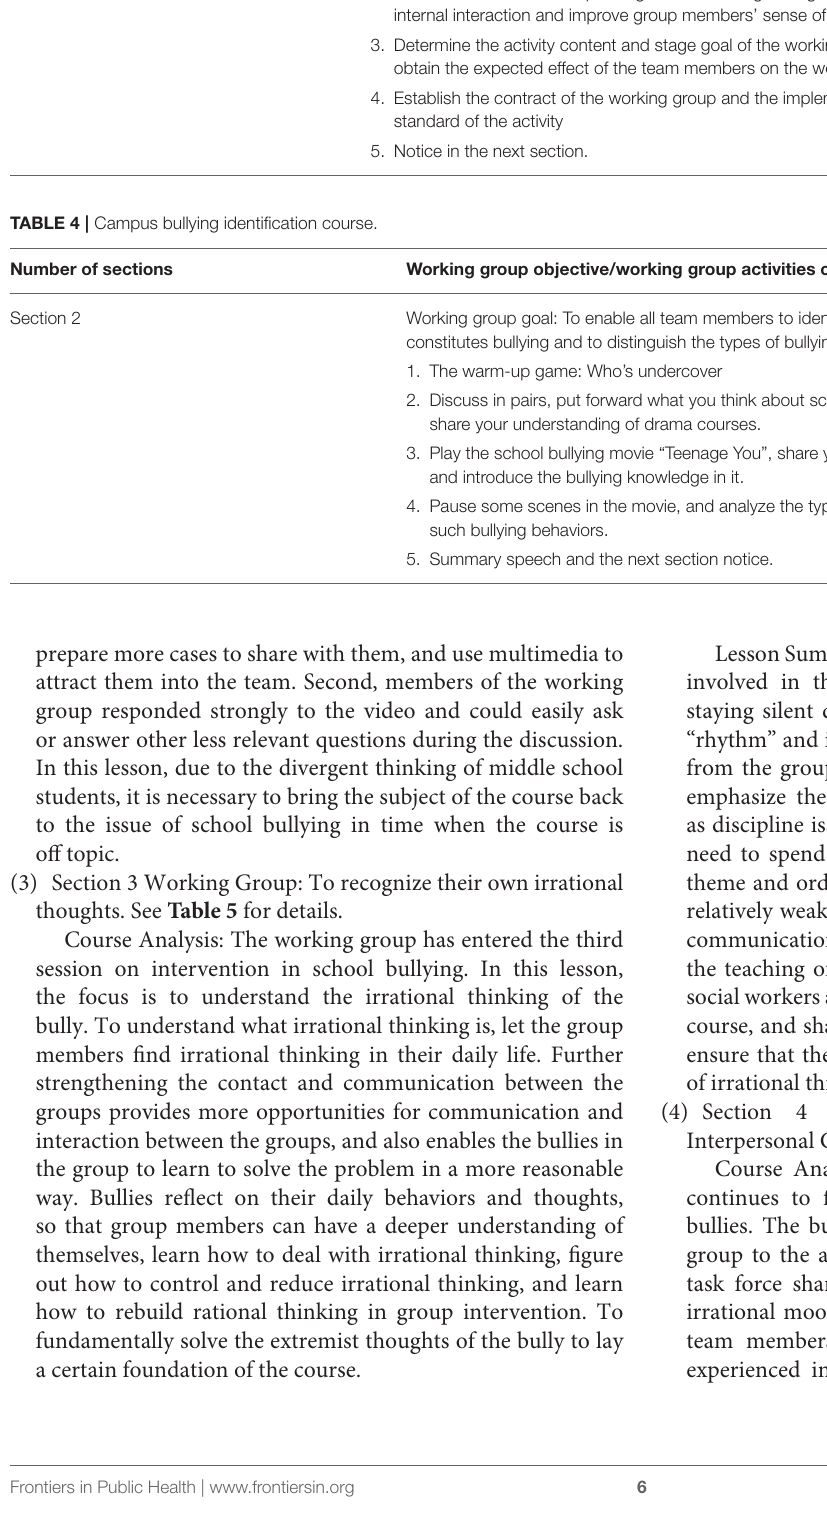
Sand table, white paper, marker pen, sand ware